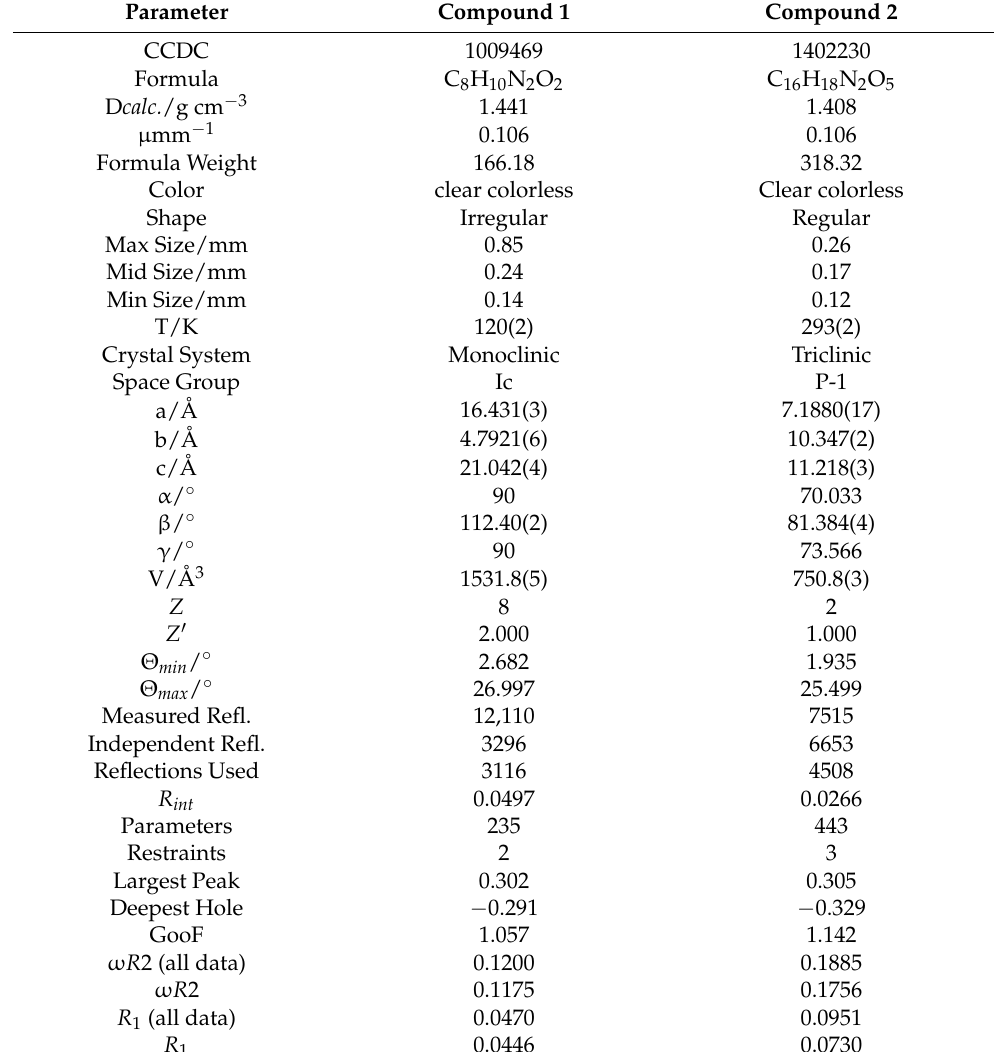
Table 1. Crystallographic data for compounds 1 and 2